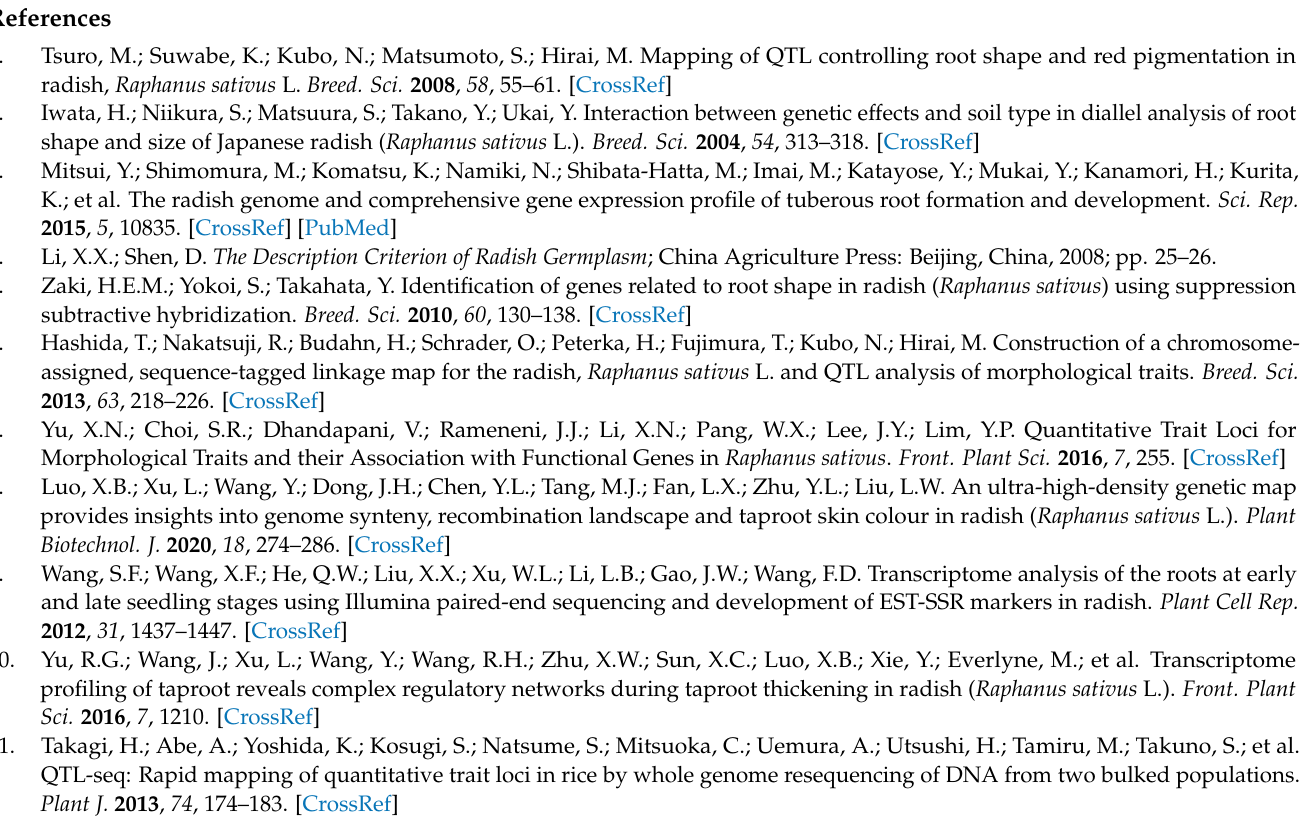
populations. Table S2: SNP index data statistics of QTL candidate regions. Table S3: Gene and annotation information in QTL candidate regions. Table S4: Expression levels of the candidate genes within the QTLs regions on radish chromosomes R4 and